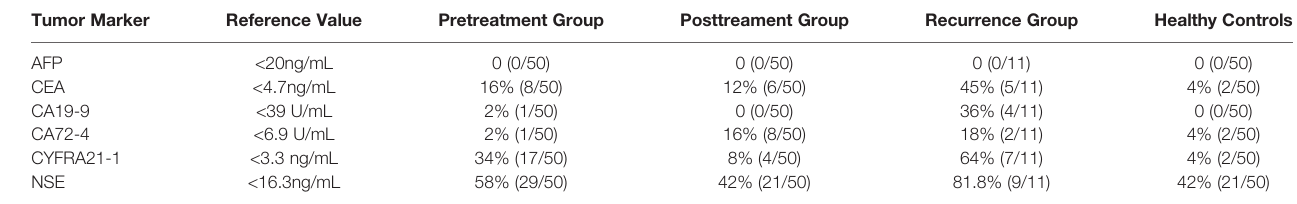
TABLE 2 | Positive rate of tumor markers in each group.